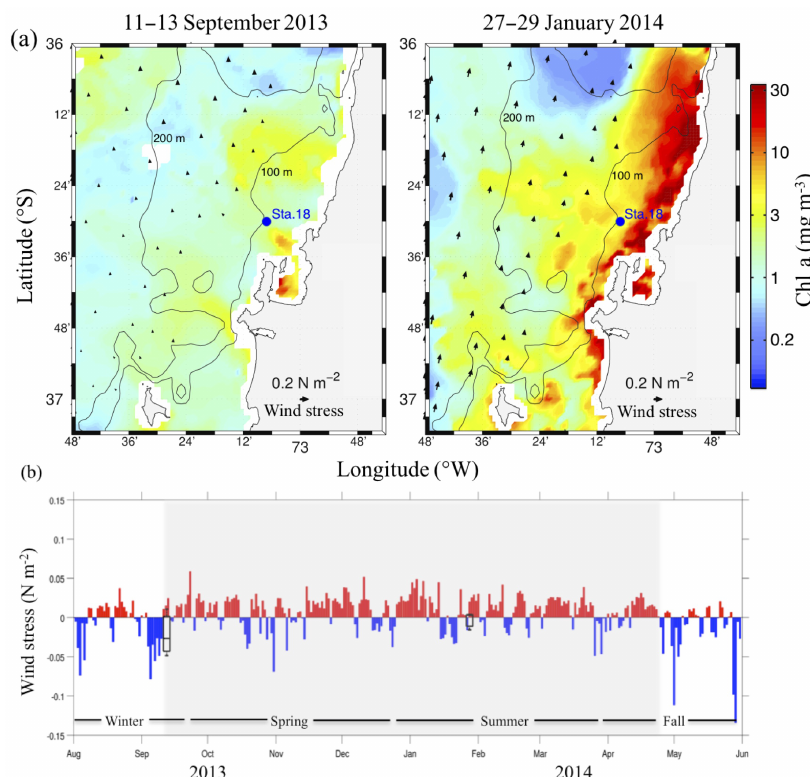
Figure 1. (a) Satellite-derived chlorophyll- a and wind stress during the period around the sampling days (left panel spring transition and right panel summer), for the study area and location of time series station 18 (Sta. 18; blue dot; 36 ◦ 30 (cid:48) S; 73 ◦ 08 (cid:48) W) off central Chile, Concepción Bay. (b) Upwelling- (red bars) and downwelling-favourable (blue bars) alongshore wind stress related to the study period (August 2013– May 2014). Box plots represent the statistical values boundaries of wind stress data for the previous week (5 days) to each sampling time. Part of the box closest and farthest to zero are the 25th and 75th percentile, respectively; horizontal lines within the box are the mean; and whiskers (error bars) are the minimum and maximum values. Shaded area represents the upwelling